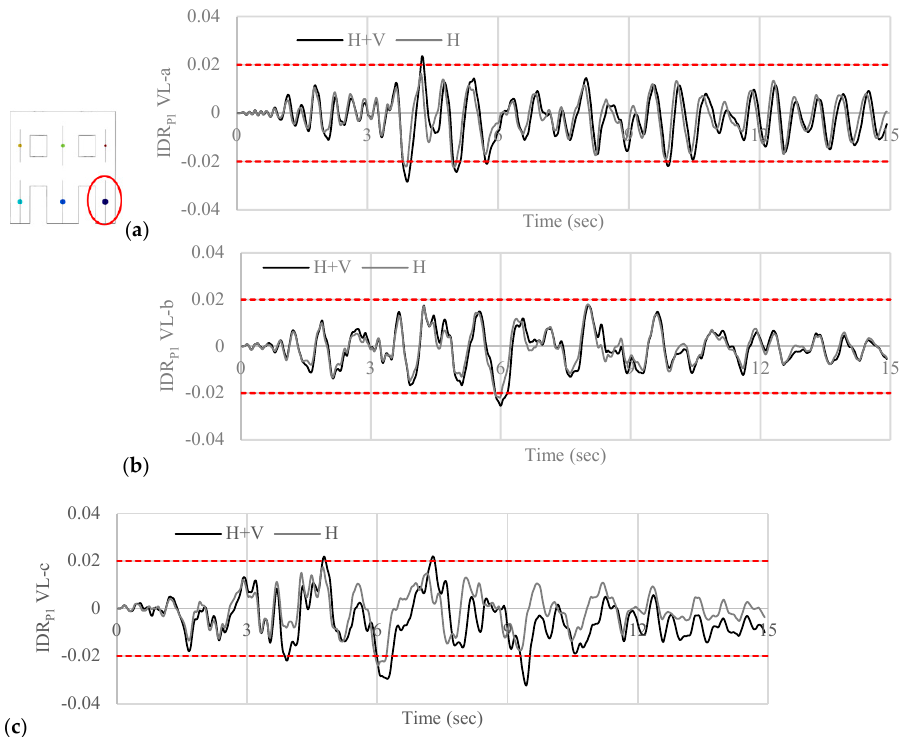
Figure 13. IDRs obtained subjecting the structure with VL-a ( a ), VL-b ( b ), and VL-c ( c ) to earthquake #2. The red lines indicate the IDR limit of 2%.